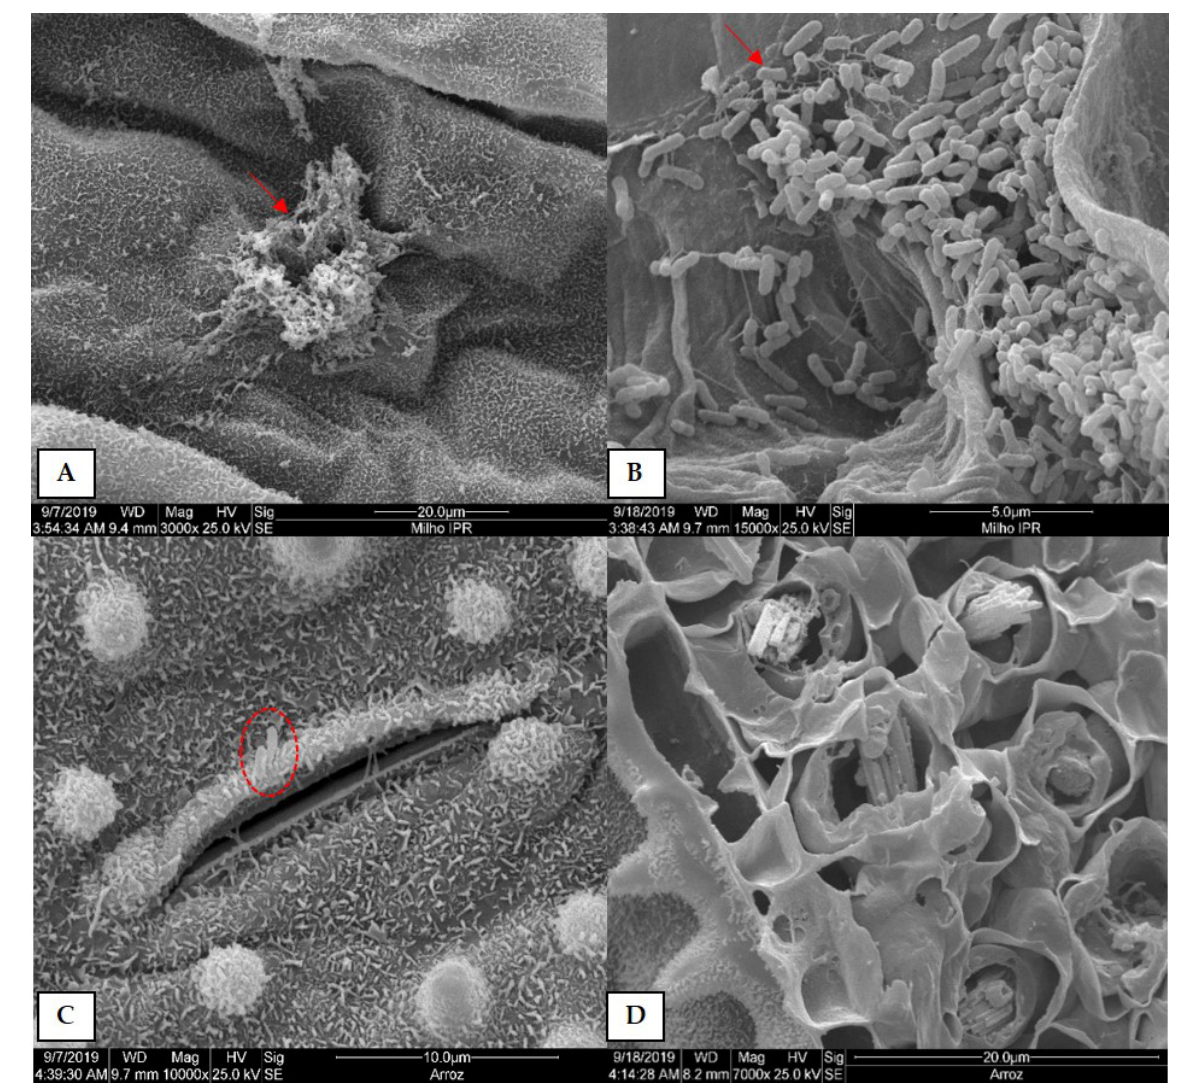
Figure 5. Scanning electron microscopy (SEM) of the adaxial surface of leaves and leaf fractures of maize cv. IPR 164 and rice cv. IPR 117 at 15 days after inoculation (DAI) with Xanthomonas vasicola pv. vasculorum ( Xvv ). ( A ) Maize cv. IPR 164 with cluster of Xvv cells in the stomatal chamber (red arrow); ( B ) maize IPR 164 with cluster of Xvv cells in the leaf mesophyll covered by amorphous material suggesting exopolysaccharides (EPS, red arrow); ( C ) rice cv. IPR 117 with Xvv cells colonizing the region close to the stomata (dashed ellipse); ( D ) rice cv. IPR 117 with internal structure of the leaf mesophyll, without evidence of bacterial cells.